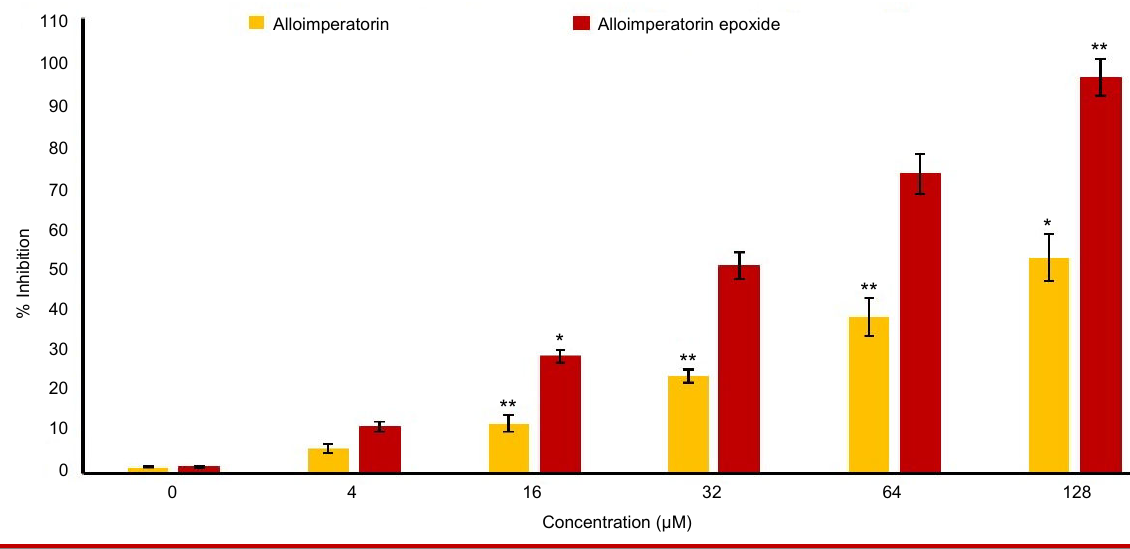
Figure 2: Cytotoxic effect of alloimperatorin and alloimperatorin epoxide in human leukemia cells (HL-60). Data are shown as the mean ± SD of three independent experiments. *p<0.05, **p<0.01, vs 0 µM